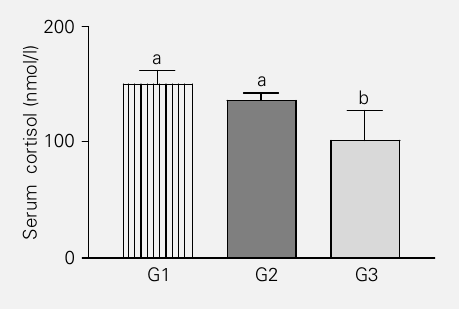
Figure 1 - Serum cortisol during a 6-month period from July to December in three groups of Thoroughbred fillies of different ages and submitted to different periods of training: G1 (1 to 2 years of age, N = 7), G2 (2 to 3 years of age, N = 9), and G3 (3 to 4 years of age, N = 8). Samples were collected weekly at the same time of day for the deter- mination of cortisol levels. Data are reported as means ± SEM. Means are different at the 0.05 level if they do not share a com- mon letter (Kruskal-Wallis test).